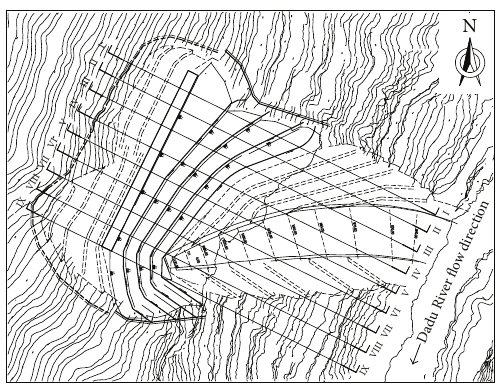
Figure 2: Layout of the right bank slope.